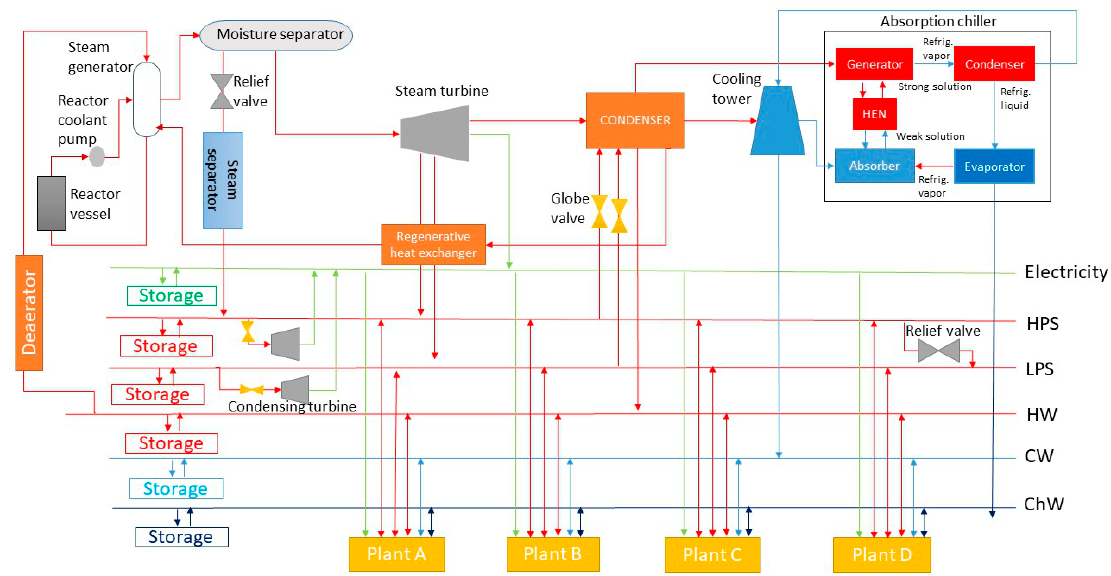
Figure 2. A graphic representation of the design of the Pressurized Water Reactor Nuclear Power Plant (PWR NPP) as a trigeneration system supplied energy to a Total Site.